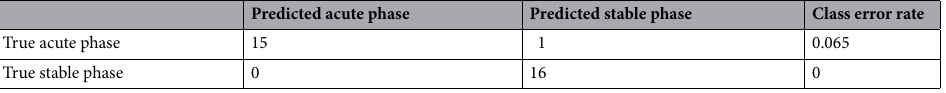
Table 2. Confusion matrix for the prediction of the status of the 32 samples from the validation set, which were randomly selected. The table shows the results of training the random forest model on the discovery set and using the trained model to predict the sample status of samples included in the validation